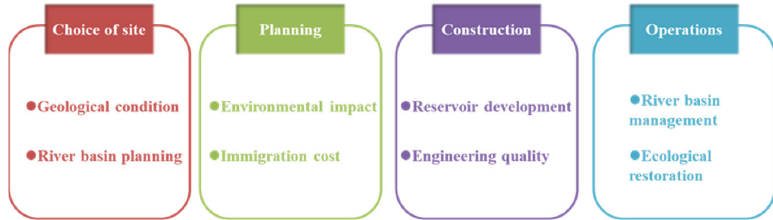
Figure 1. Planning system of hydropower